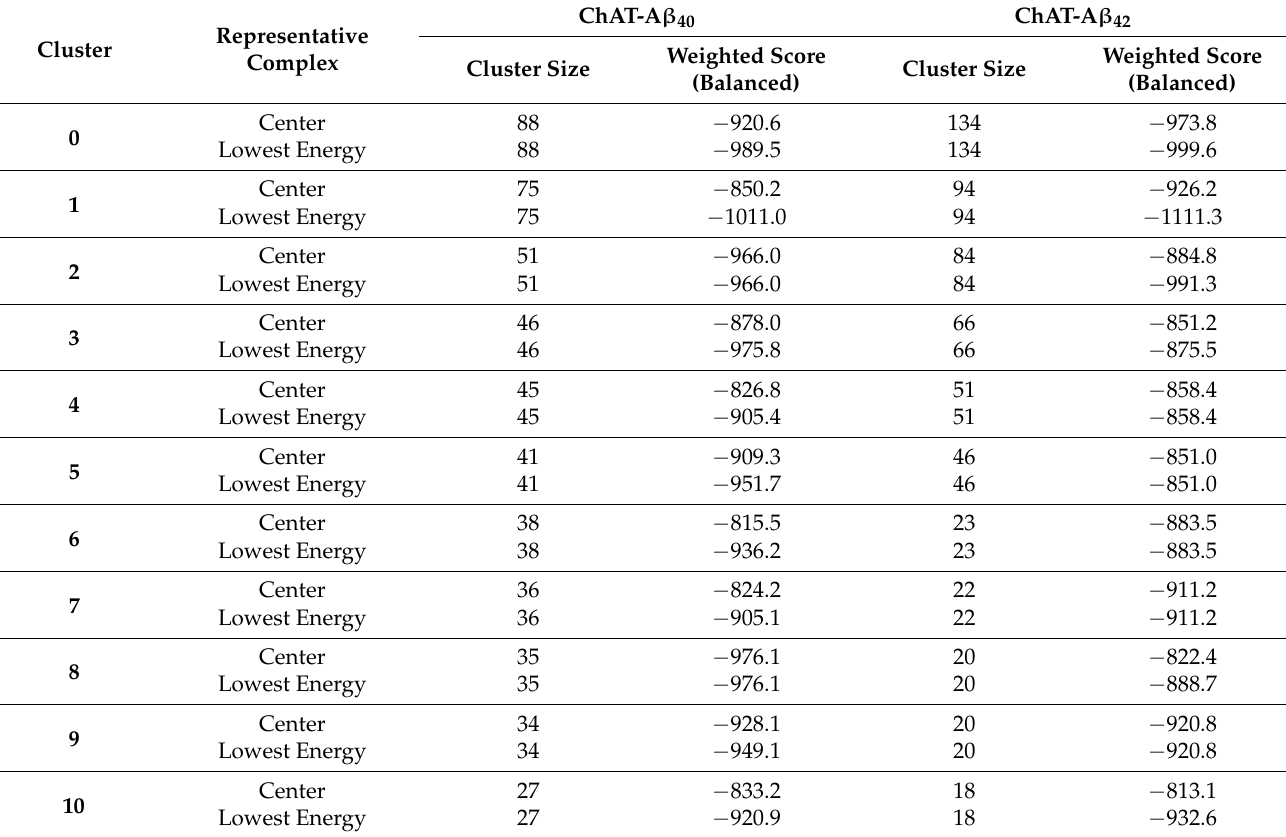
Table 1. Probabilistic binding clusters of A β 40 and A β 42 on